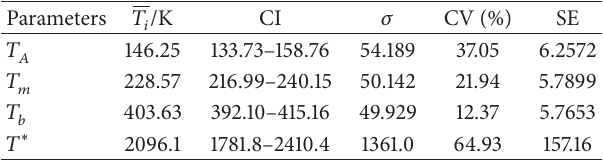
Table 2: Descriptive statistics on temperatures’ parameters: arith- metic mean ( 𝑇 𝑖 ), Confidence Interval (CI), standard deviation ( 𝜎 ), coefficient of variation (CV), and standard error (SE).